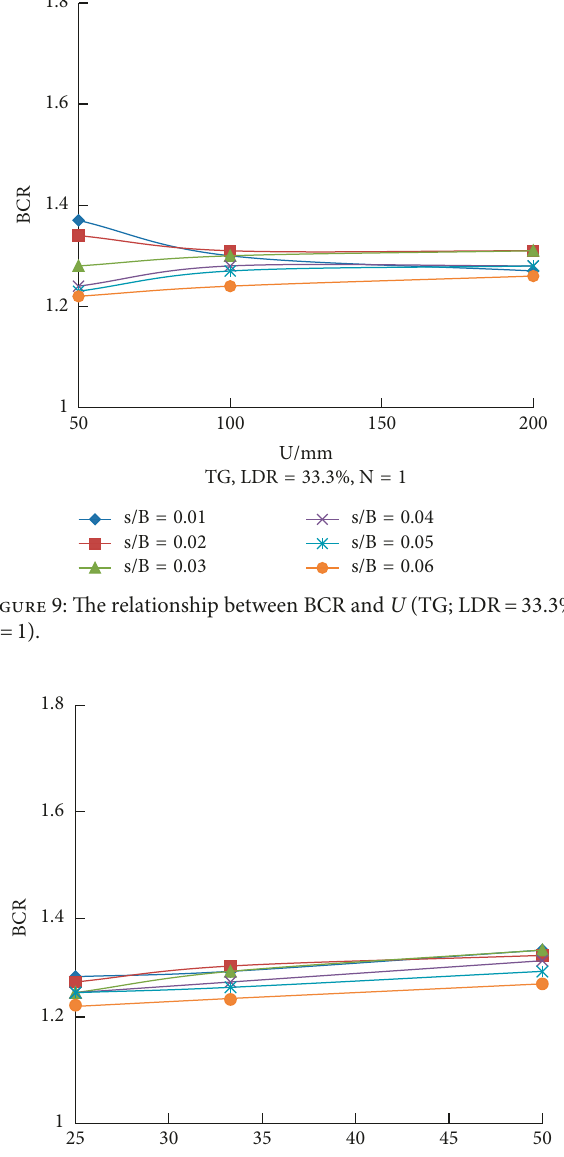
Figure 10: The relationship between BCR and LDR (TG; U 100mm; N (cid:30) (cid:30)